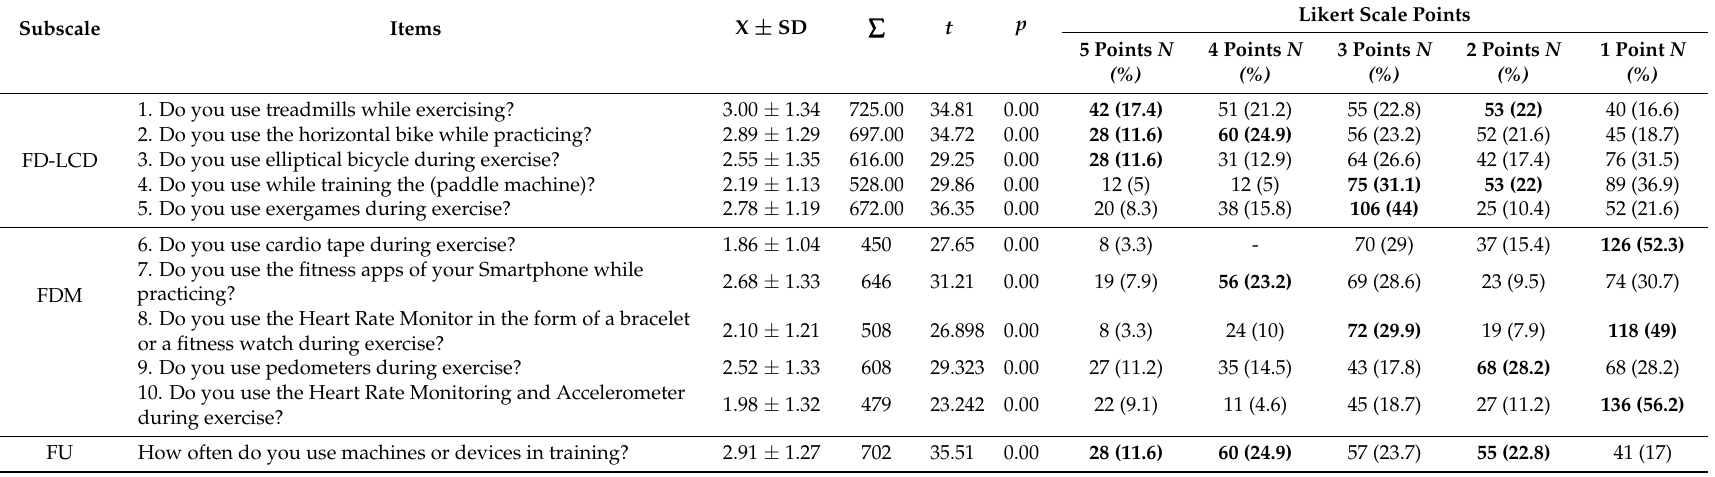
Table 5. The statistical analysis of the average responses according to the Likert scale (5) per item in the assessment of the use of fitness technology with the monitoring